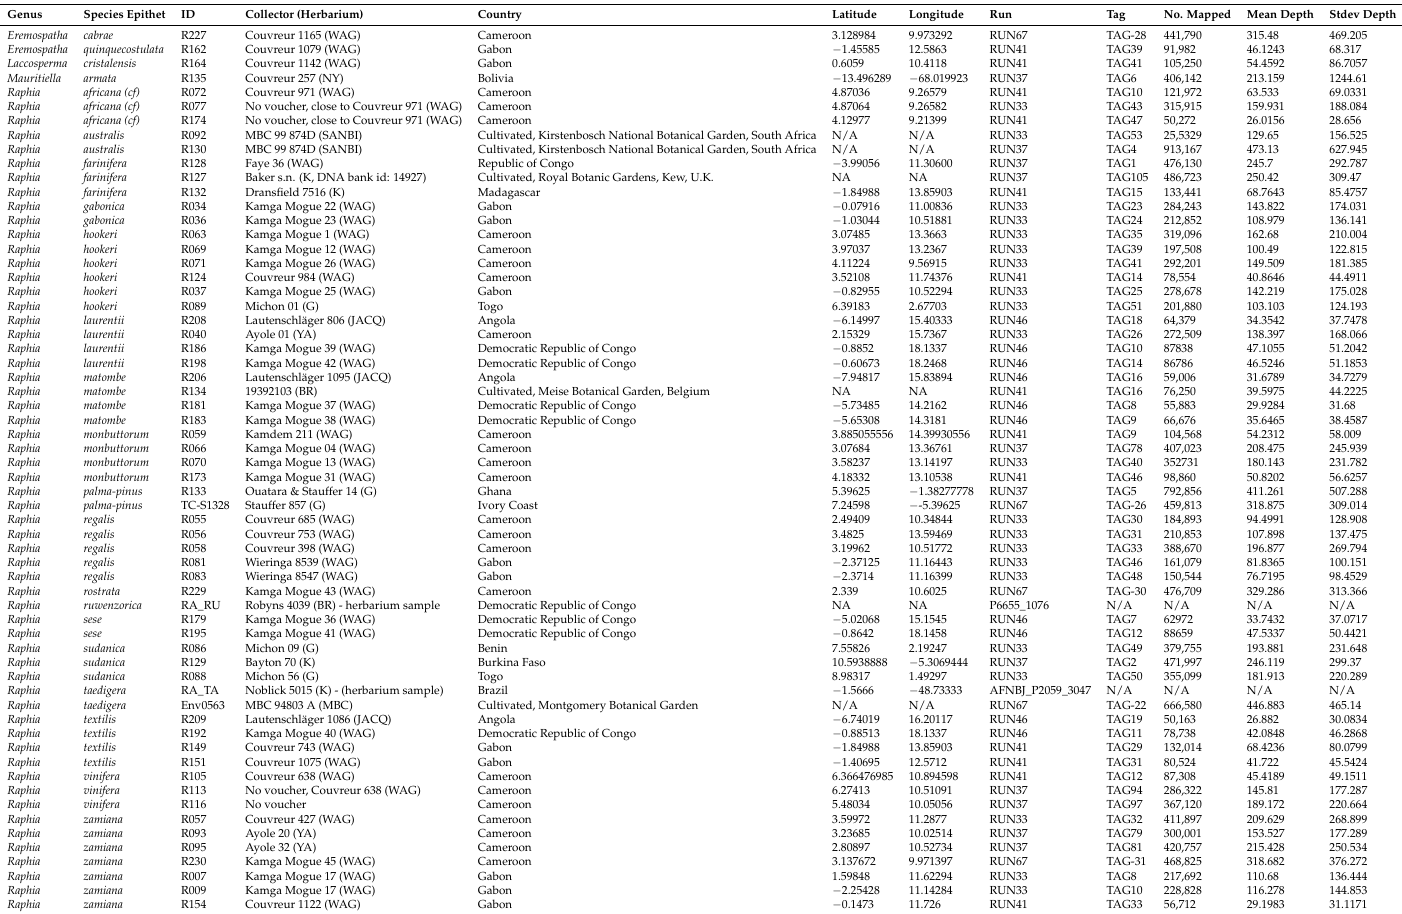
Table A1. Herbarium specimen collector and number and herbarium origin, coordinates (in decimal degrees) and country of collection for all samples included in our study. All samples were extracted from silicagel dried leaves, expect when stated otherwise. The last five columns refer to the sequencing identification (TAG and INDEX used) and different sequencing statistics (number of reads mapped to the reference; mean and standard depth,